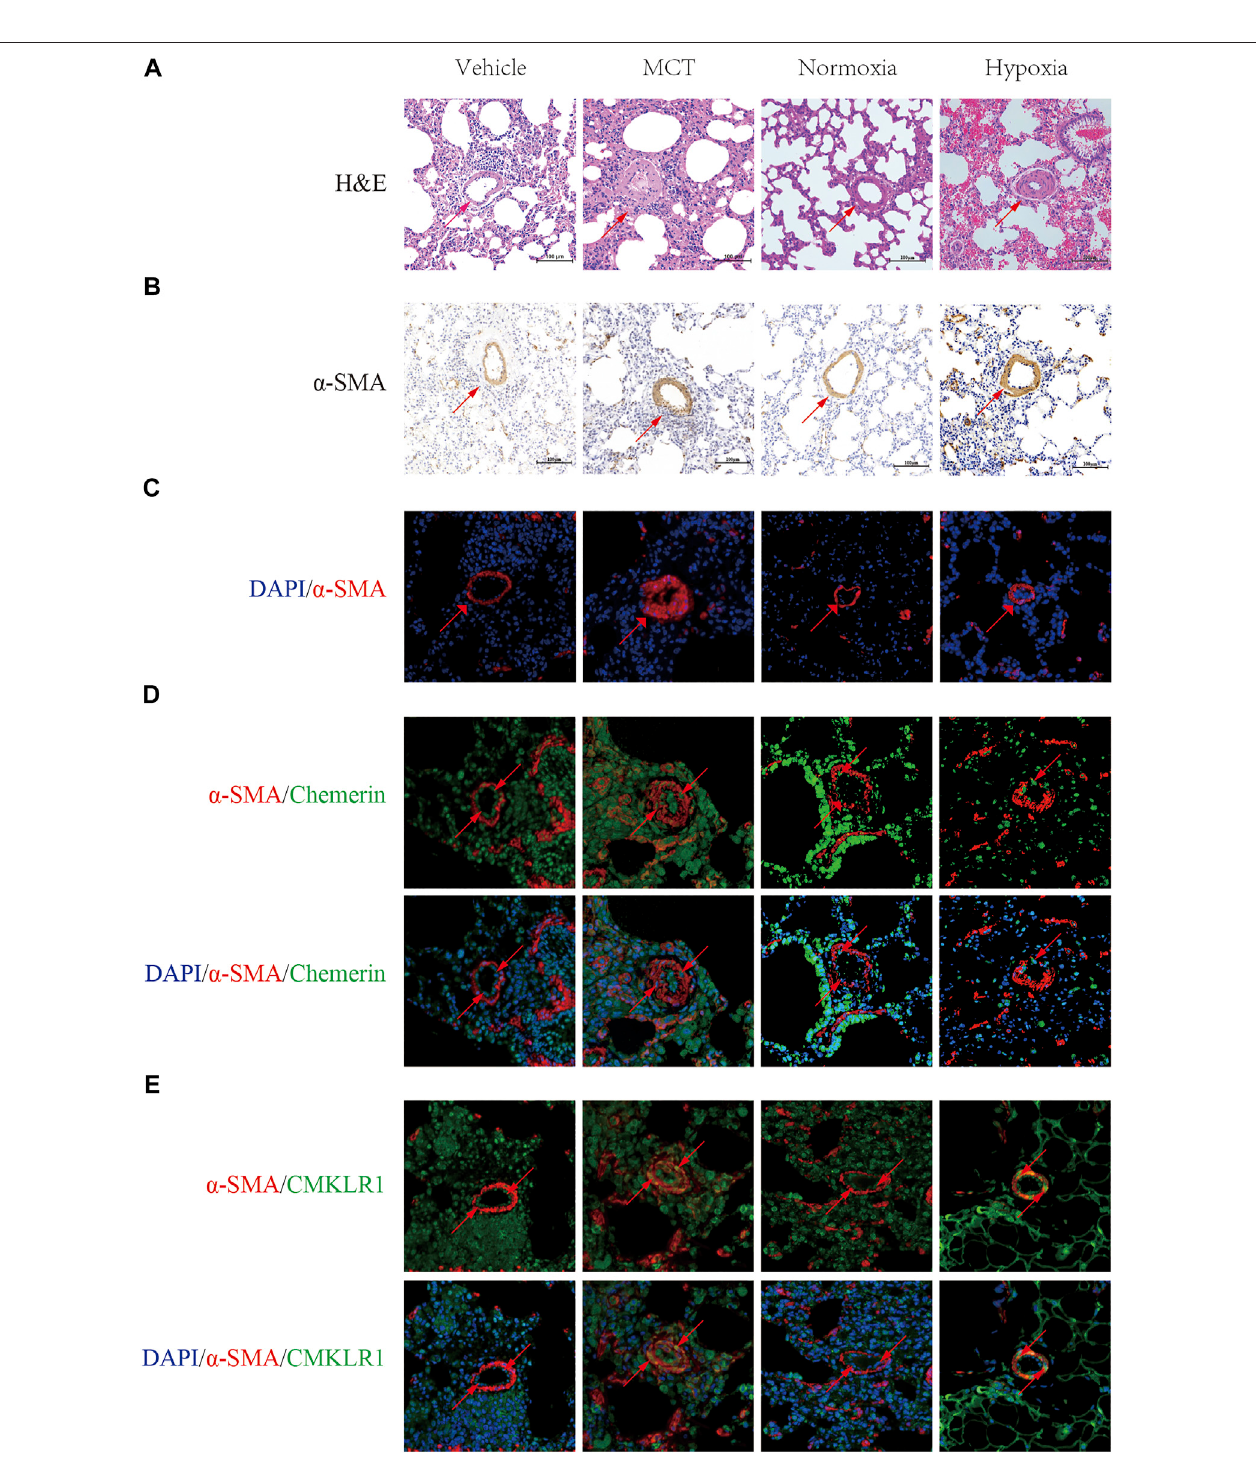
FIGURE 1 | Localization and expression of Chemerin and its receptor CMKLR1 in rat lungs. Characterizing the localization of chemerin and its receptor CMKLR1 expression in rat lung tissues. (A) Representative images of H&E-stained lung tissues (original magni fi cation, × 200, scale bars, 100 um). (B) Immunohistochemistry staining of pulmonary arteries stained with α -SMA (original magni fi cation, × 200, scale bars, 100 um). (C) Immuno fl uoresce staining of pulmonaryarteriesstainedwith α -SMA(red)andDAPI(blue)(originalmagni fi cation,×400,scalebars,50 um). (D) Representativeimmuno fl uorescenceimages of chemerin (green), α -SMA (red) and DAPI (blue) in normal and PH rat lung tissues (original magni fi cation, × 400, Scale bars, 50 um). (E) Representative immuno fl uorescence images of CMKLR1(green), α -SMA (red) and DAPI (blue) in normal and PH rat lung tissues (original magni fi cation, × 400, Scale bars, 50 um).